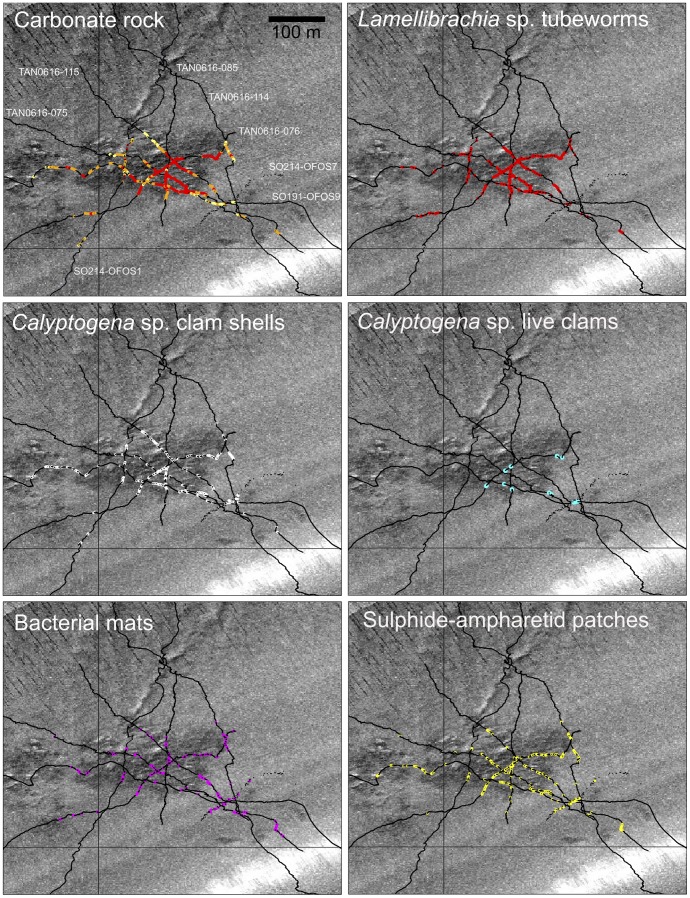
North Tower seep, Opouawe Bank.Observations from towed video camera transects showing distributions of: authigenic carbonate rocks (red, “chemoherm”; orange, “large blocks (>20 cm)”; yellow, “small blocks (<20 cm)”); Lamellibrachia sp. siboglinid tubeworms; disarticulated shell valves of Calyptogena sp. vesicomyid clams; live Calyptogena sp. clams; bacterial mats, and dark, sulphide-rich sediment patches colonised by ampharetid polychaetes. Transects are plotted against a side-scan sonar image of the seabed generated during SO191-2 (darker pixels indicate stronger acoustic backscatter). Labels in the top left panel show voyage and deployment number for each transect: TAN0616, RV Tangaroa 2006; SO191, RV Sonne 2007; SO214, RV Sonne 2011.